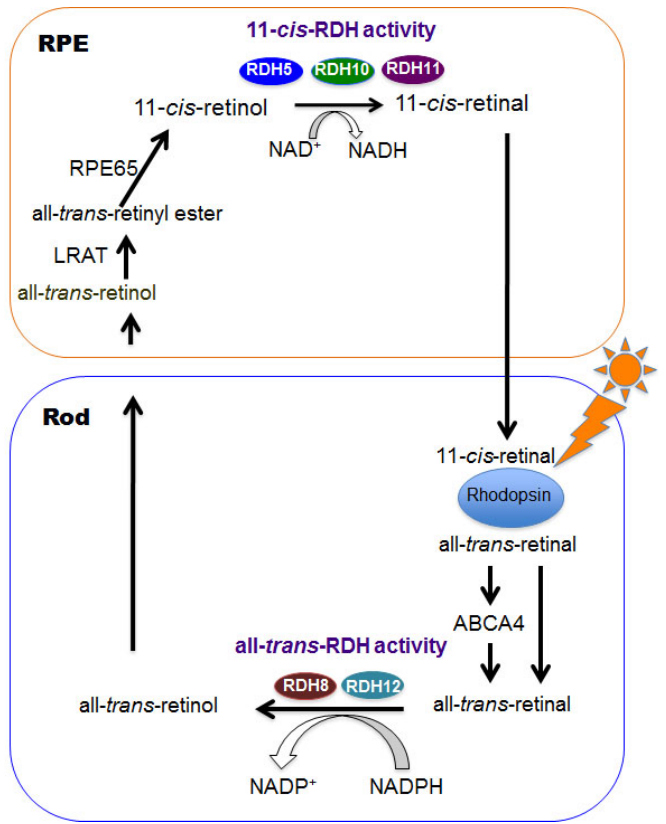
Figure 1. Rod visual cycle is shown. Visual chromophores, vitamin A derivatives, are regenerated via this cycle. RDHs play an important role for this process. RPE, retinal pigmented epithelium; RDH, retinol dehydrogenase; LRAT, lecithin retinol acyltransferase; RPE65, retinal pigmented epithelium-specific 65-kDa; ABCA4, ATP-binding cassette transporter